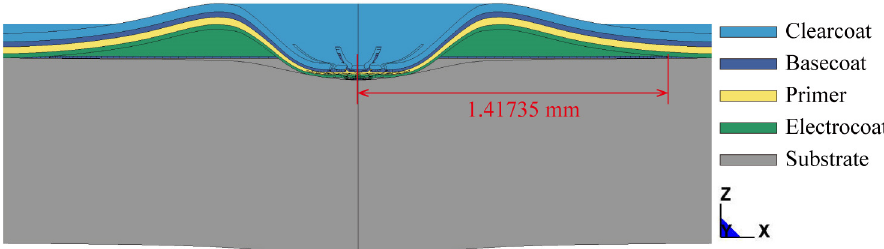
Figure 9. The predicted delamination area between coating and substrate. The model shown has been reflected in Y - Z plane.